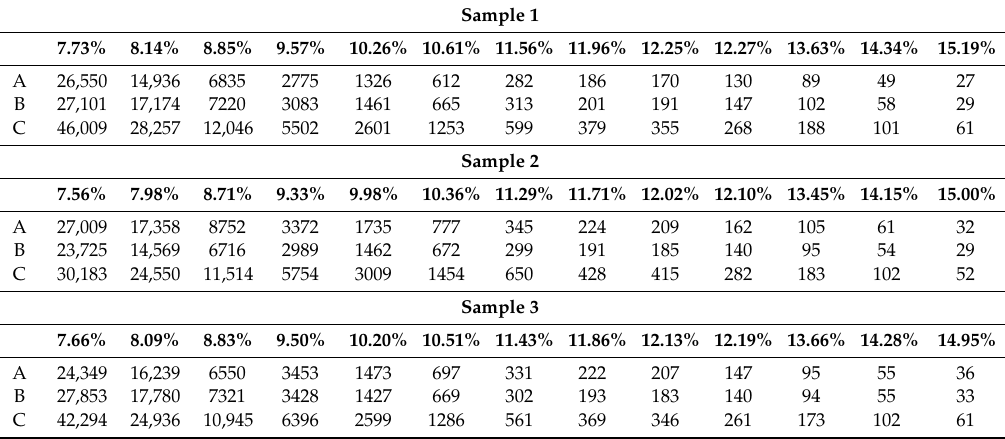
Table 1. Calculated resistances from the RC method in megaohms